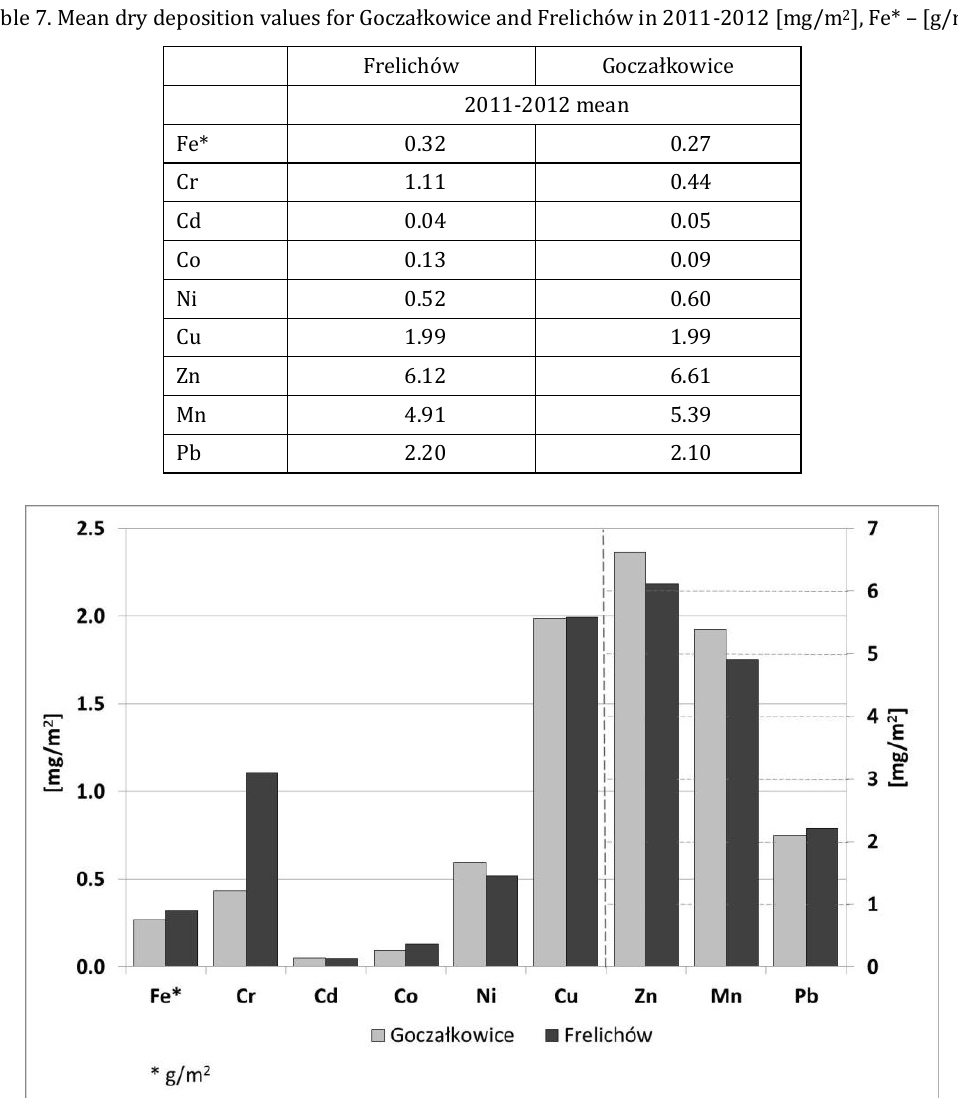
Fig. 15. Mean dry deposition values of the selected metals in Goczałkowice and Frelichów in 2011-2012 in [mg/m 2 ], Fe* – [g/m 2